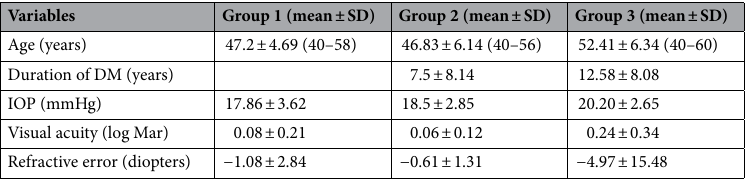
Table 1. Demographic features of control and controlled diabetic patients with and without